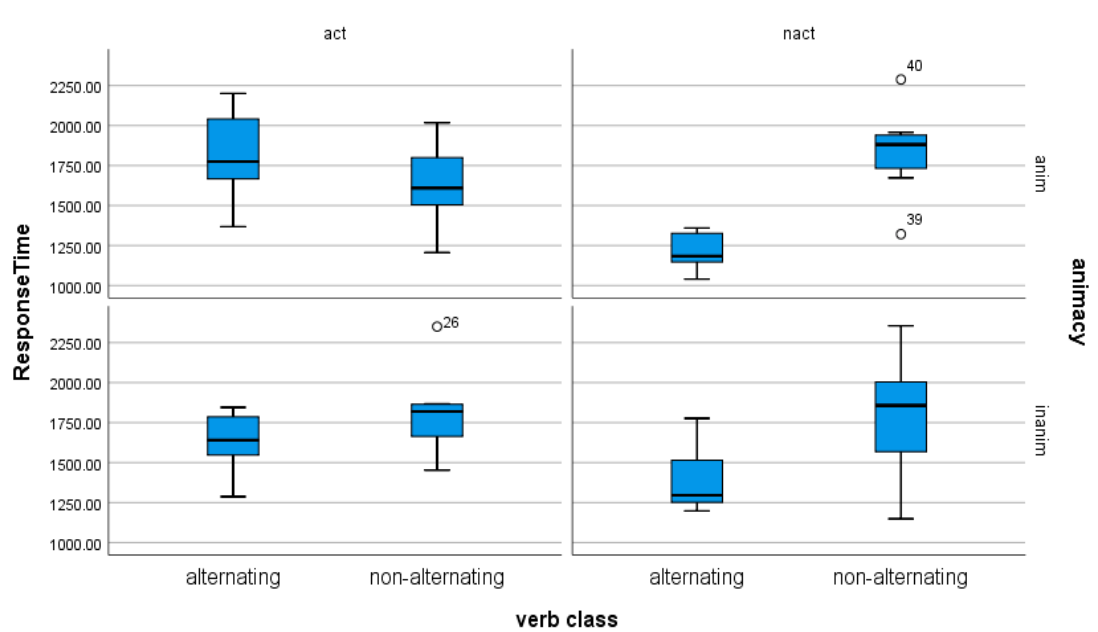
Figure 6. RTs per verb class across conditions in the AJ task.